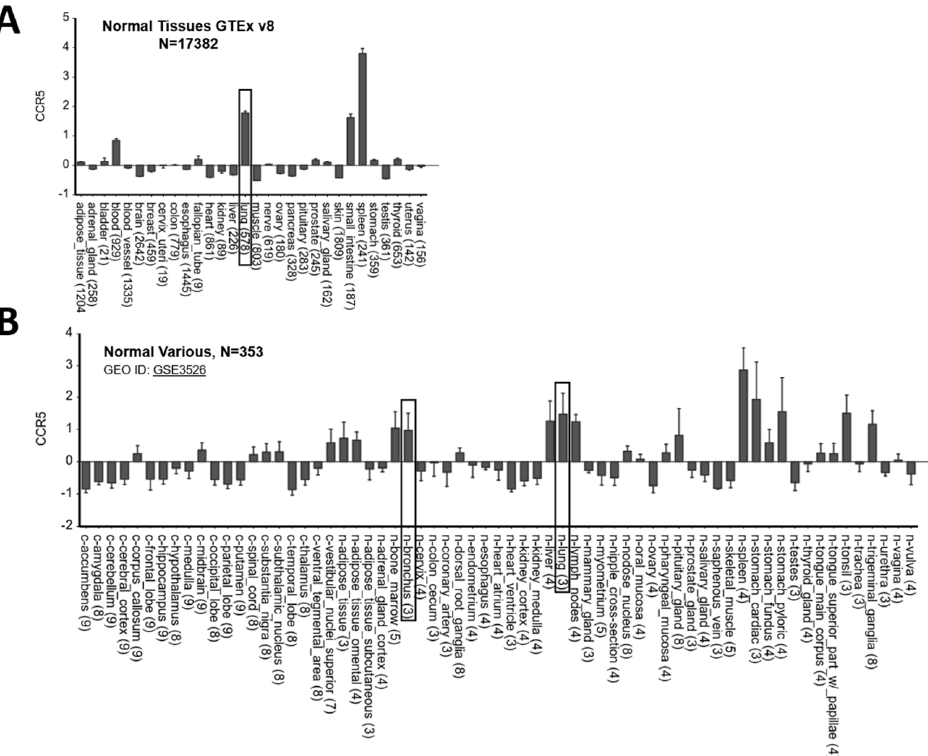
Figure 1. CCR5 is highly expressed in lung and bronchus. ( A ) Gene expression data of 17,382 samples categorized in 30 different normal tissues obtained from GTEx database and ( B ) of 353 samples categorized in 69 different normal tissues obtained from Roth et al. study. The gray boxes highlight tissues from lung and bronchus. Data are plotted by using R2: Genomics Analysis and Visualization Platform (http://r2.amc.nl, accessed on 10 May 2021).